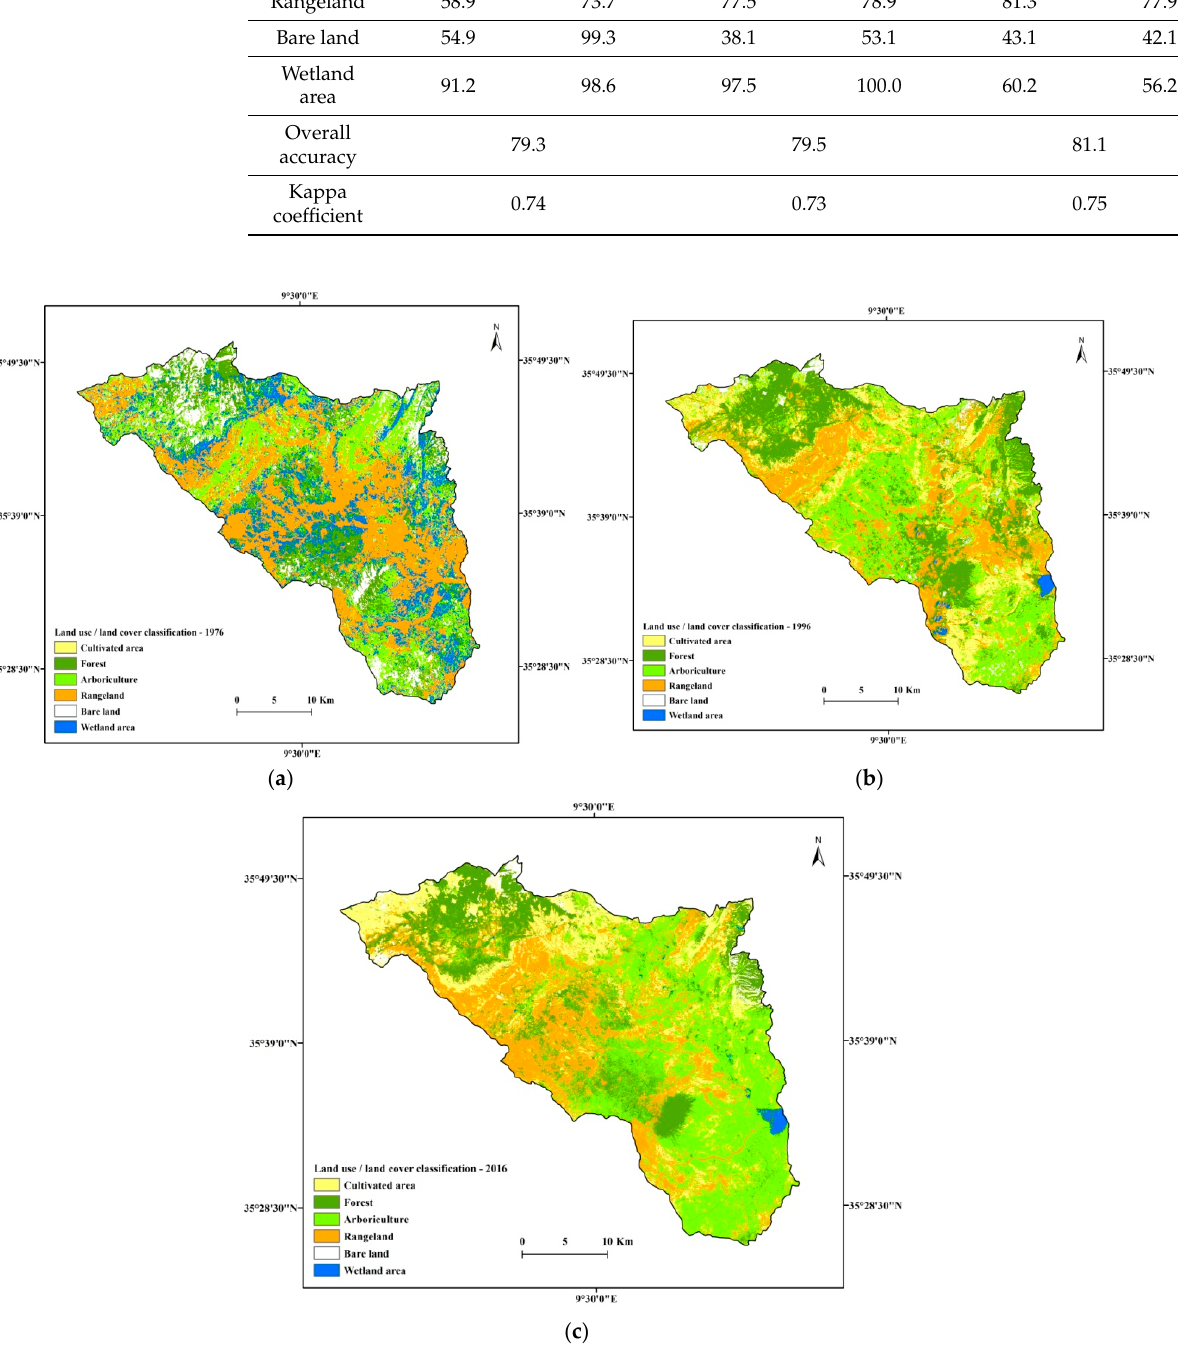
Figure 5. Land use/land cover maps for the Merguellil Wadi Basin for ( a ) 1976, ( b ) 1996, and ( c ) 2016.